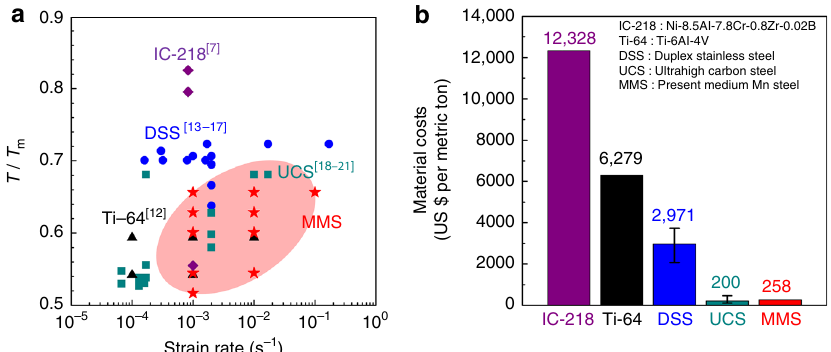
Fig. 4 Tensile deformation parameter maps and material costs of various superplastic alloys including the present Fe-6.6Mn-2.3Al (wt.%) steel. a Tensile deformation temperature over melting temperature ( T / T m ) – strain rate (s − 1 ) maps for superplasticity. b Comparison of material costs (US $ per metric ton) of